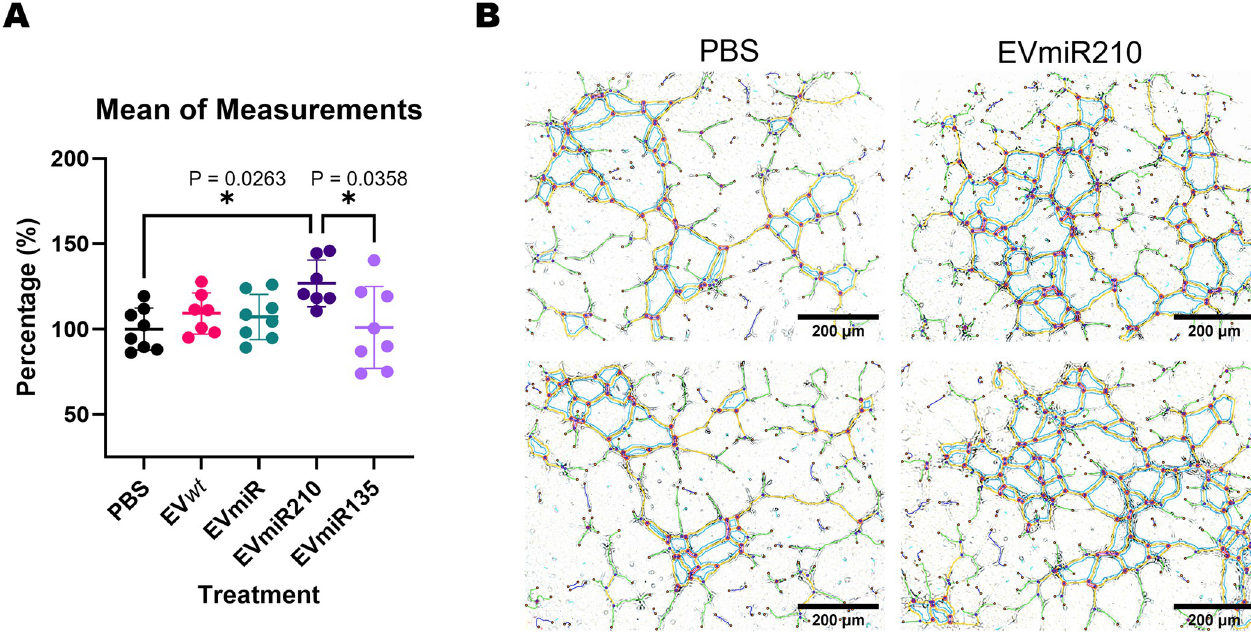
Fig 5. Angiogenic activity of EVmiR210 in endothelial cells. (A) Mean of the five structures analyzed in HUVECs treated with PBS or MSC-EVs at the 7-h time point. (B) Comparative image of HUVECs treated with PBS or EVmiR210 with tubular structures, which are highlighted by Angiogenesis Analyzer in ImageJ software. EV wt s = MSC wt -derived EVs; EVmiRs = MSCmiR-derived EVs; EVmiR210s = MSCmiR210-derived EVs; EVmiR135bs = MSCmiR135b- derived EVs. The significance of the differences was assessed by one-way ANOVA and Bonferroni correction for the post hoc analysis.